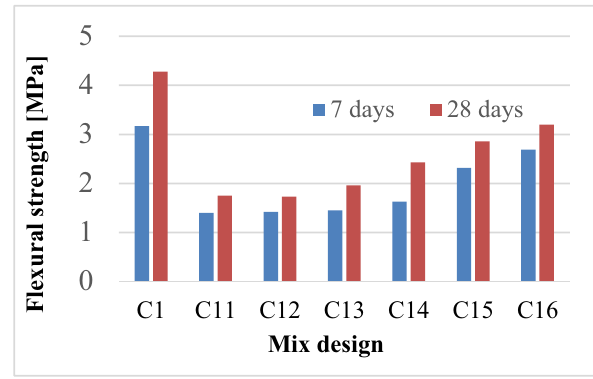
Figure 6: Flexural strength for di ff erent mixes.